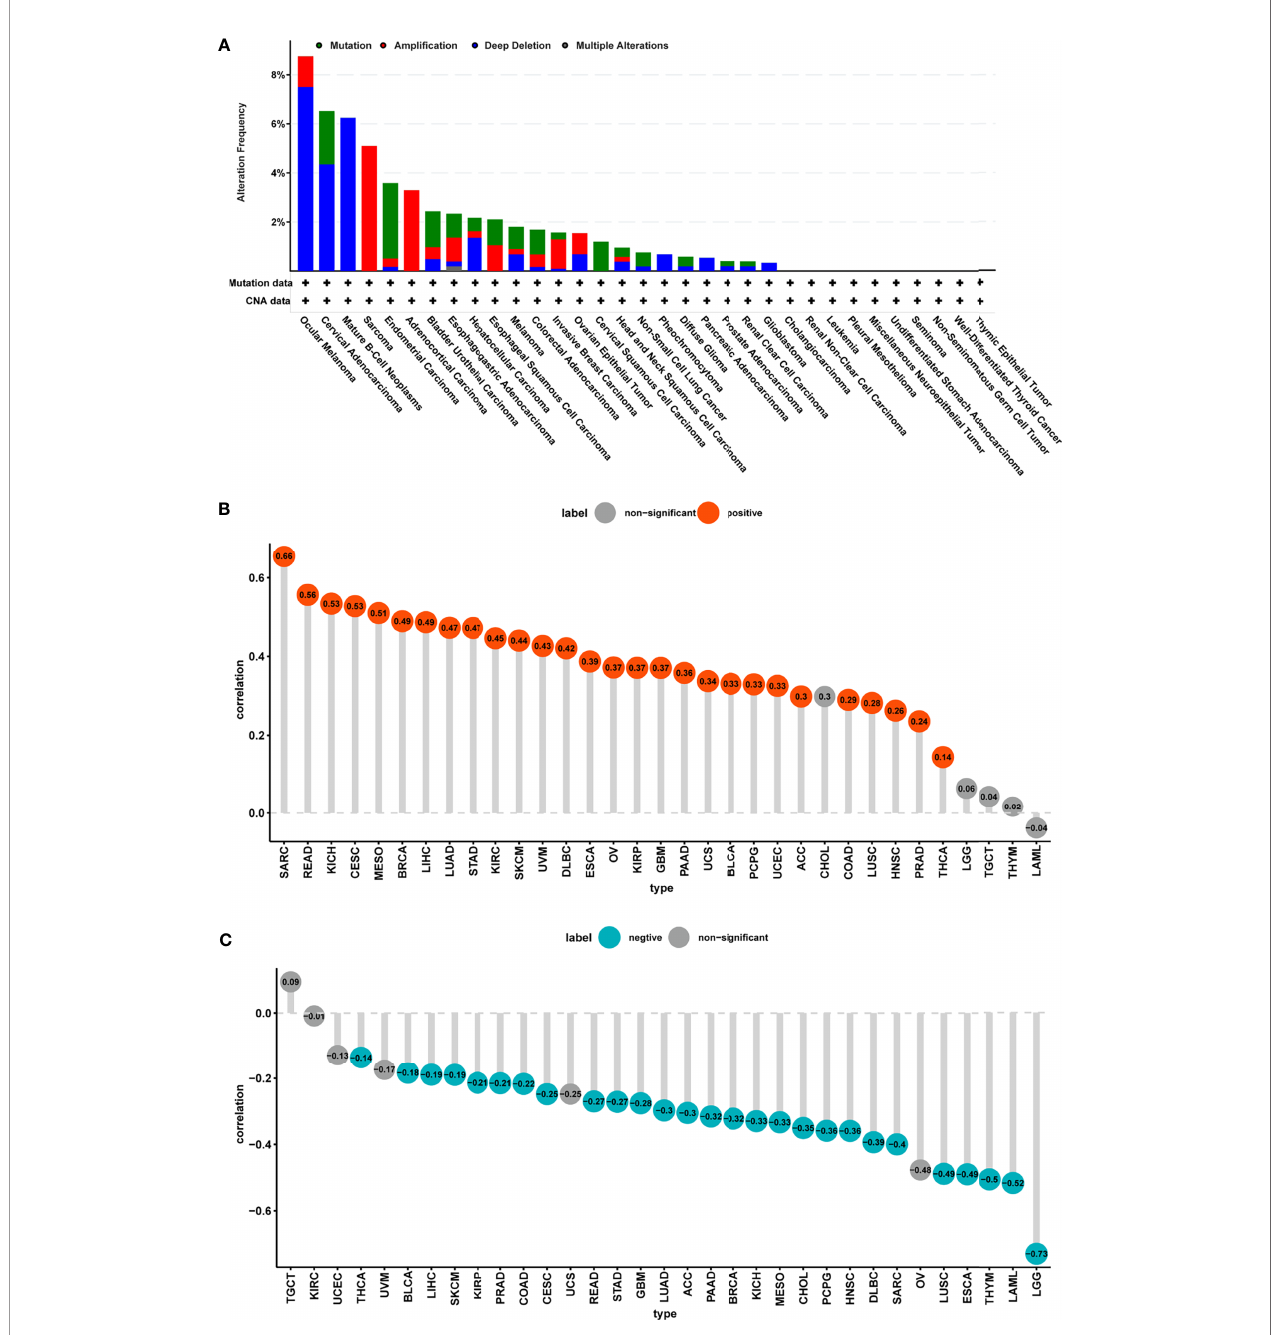
FIGURE 5 | CNA and DNA methylation of FUCA2 in pan-cancer. (A) The mutation and CNA status of FUCA2 in TCGA-pan-cancer using cBioportal database. (B) Correlation between expression levels of FUCA2 mRNA and DNA copy number. Red color represents signi fi cant results (p < 0.05). (C) Correlations between mRNA level of FUCA2 and DNA methylation. Blue color represents signi fi cant results (p <